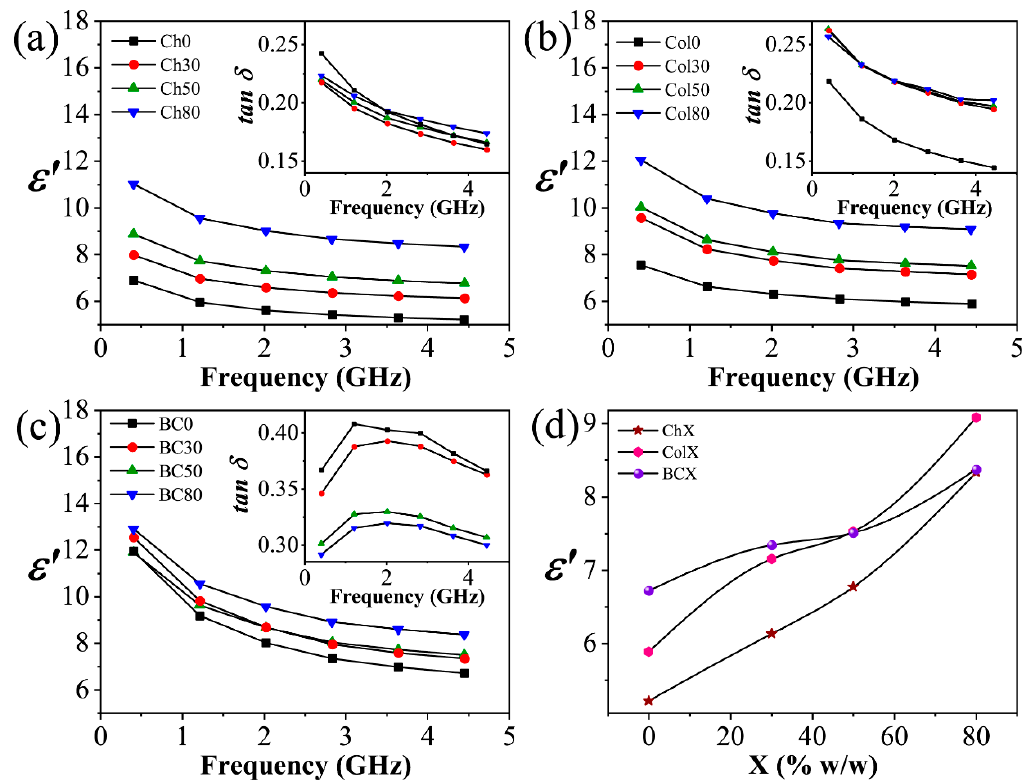
Figure 6. Variation of ε ’ and tan δ (inset graph) of biocomposites with applied frequency: ( a ) Ch-based composite films; ( b ) Col-based composite films; and ( c ) BC-based composite films. ( d ) Variation of ε ’ at 4.45 GHz vs. X amount of SPIONs (% w/w ) in the matrix.